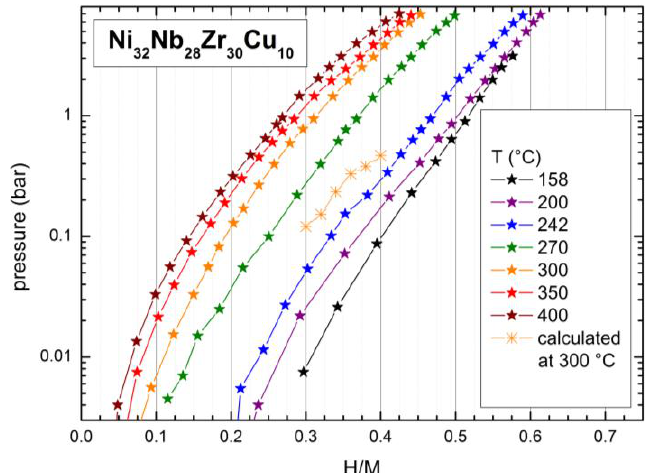
Figure 2. Pressure-composition isotherms measured at various temperature between 158 and 400 °C.